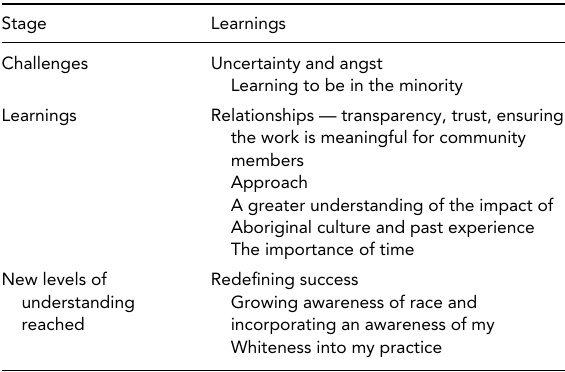
Summary of Challenges, Learnings and New Levels of Understanding